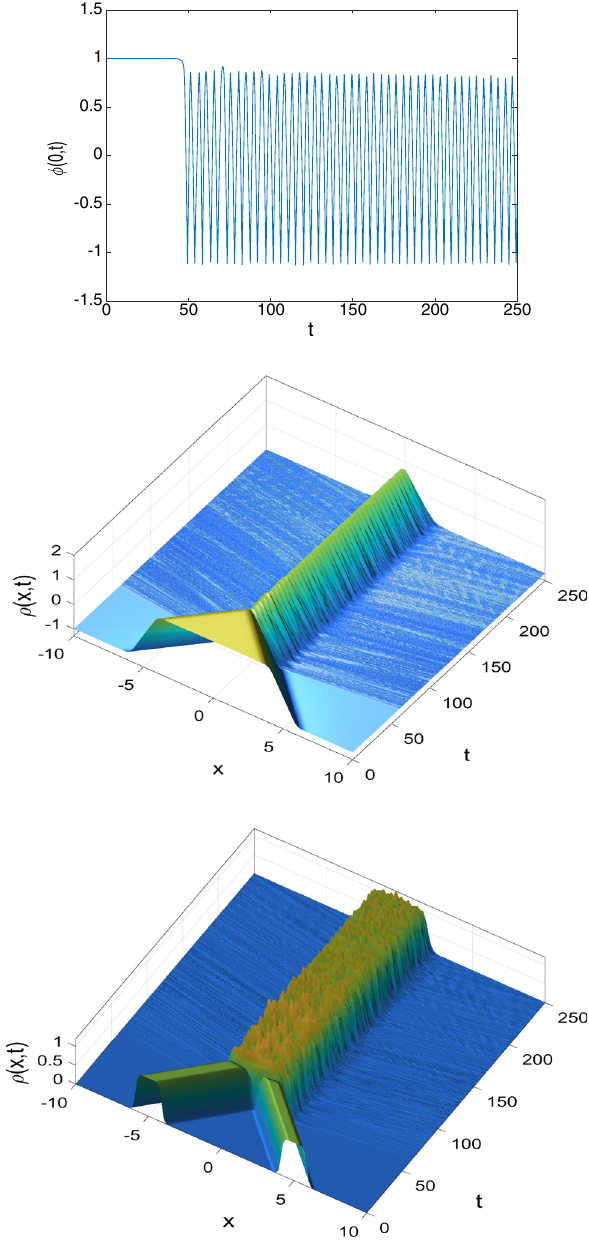
Fig. 8 Long-lived compactlike oscillon after the collision of compact- like kinks with n = 4 and u = 0 . 08098484 Presence of oscillons The collision of kinks is almost elastic, meaning that only a smallfractionofthescalarfieldenergyisradiatedaway.Also, the formation of a bound oscillating scalar field at the origin is the primary outcome for u < u crit . On the other hand, in general, the collision of compactlike defects is inelastic, with a considerable amount of energy of the scalar field radi- ated. However, there are specific values of the impact